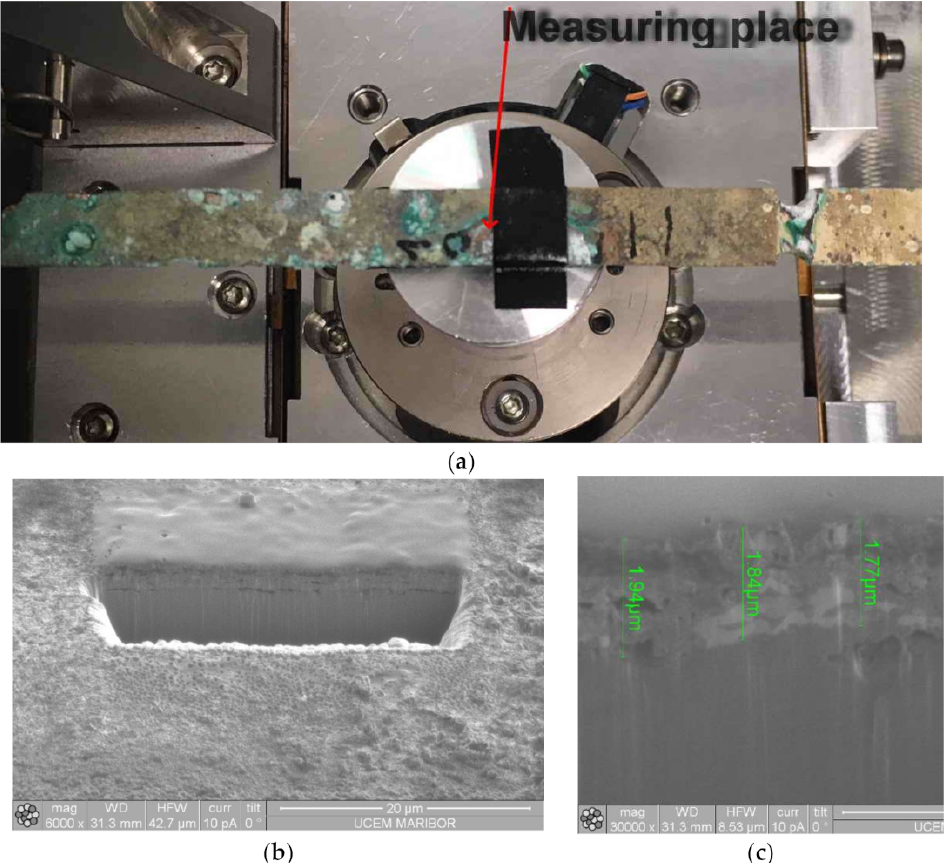
Figure 5. Focus ion beam (FIB) analyses, ( a ) place 1 of analysis, ( b ) photo view of sample, ( c ) mea- surement value of the corrosion layer in nm on a sample 1 year in the sea (sample C with 30,000 magnification, Table